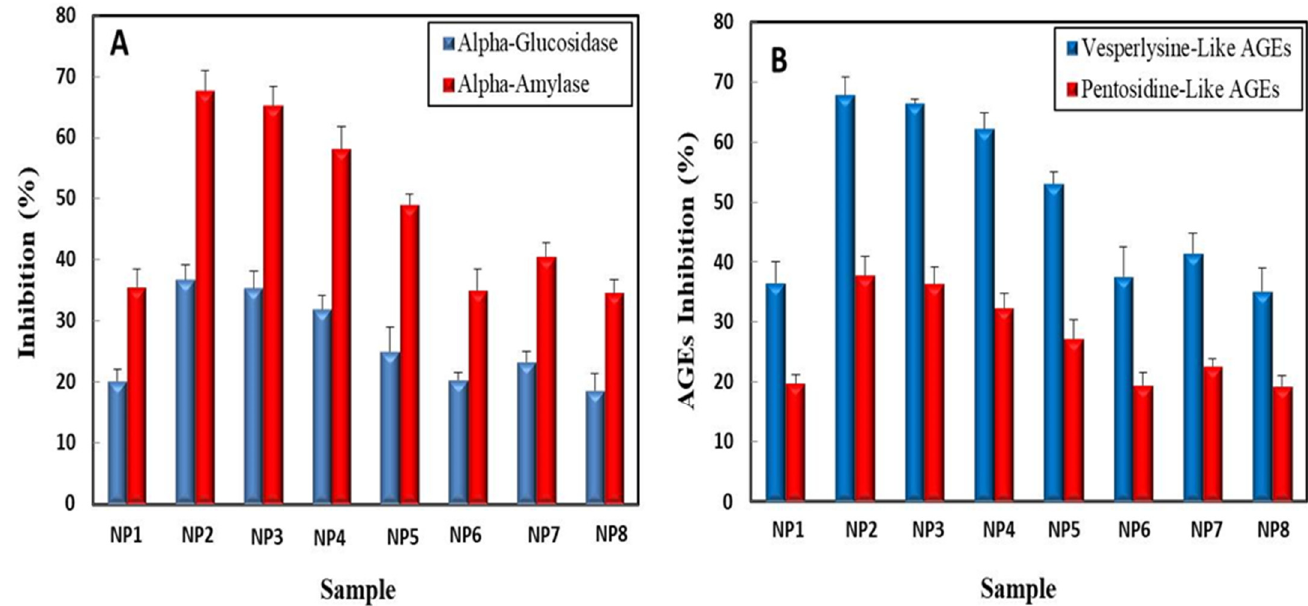
Figure 14. ( A ) Anti-diabetic activities of monometallic and bimetallic NPs assessed through the inhibition of α -glucosidase and α -amylase. ( B ) Anti-glycation activity of monometallic and bimetallic NPs measured through the inhibition of AGE production. Data represent the mean of 3 replicates ± SE. (Note—NP1: control AgNPs; NP2: UV-C mediated AgNPs; NP3: control ZnONPs; NP4: UV-C mediated ZnONPs; NP5: control bimetallic Ag–ZnONPs (0.1/0.1); NP6: UV-C mediated bimetallic Ag–ZnONPs (0.1/0.1); NP7: control bimetallic Ag–ZnONPs (0.1/0.5); NP8: UV-C mediated bimetallic Ag–ZnONPs (0.1/0.5)).